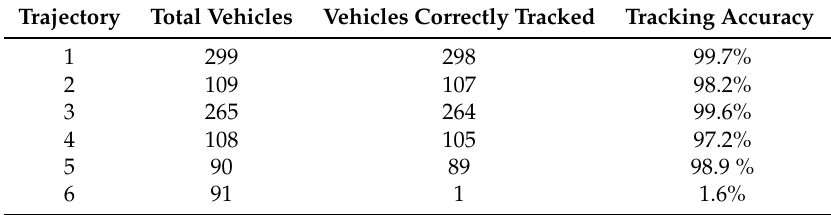
Table 3. Results of a single camera tracking evaluation for each possible trajectory (cf. Figure 7) including trajectory 6 which was not intended for tracking due to inadequate deployment of the